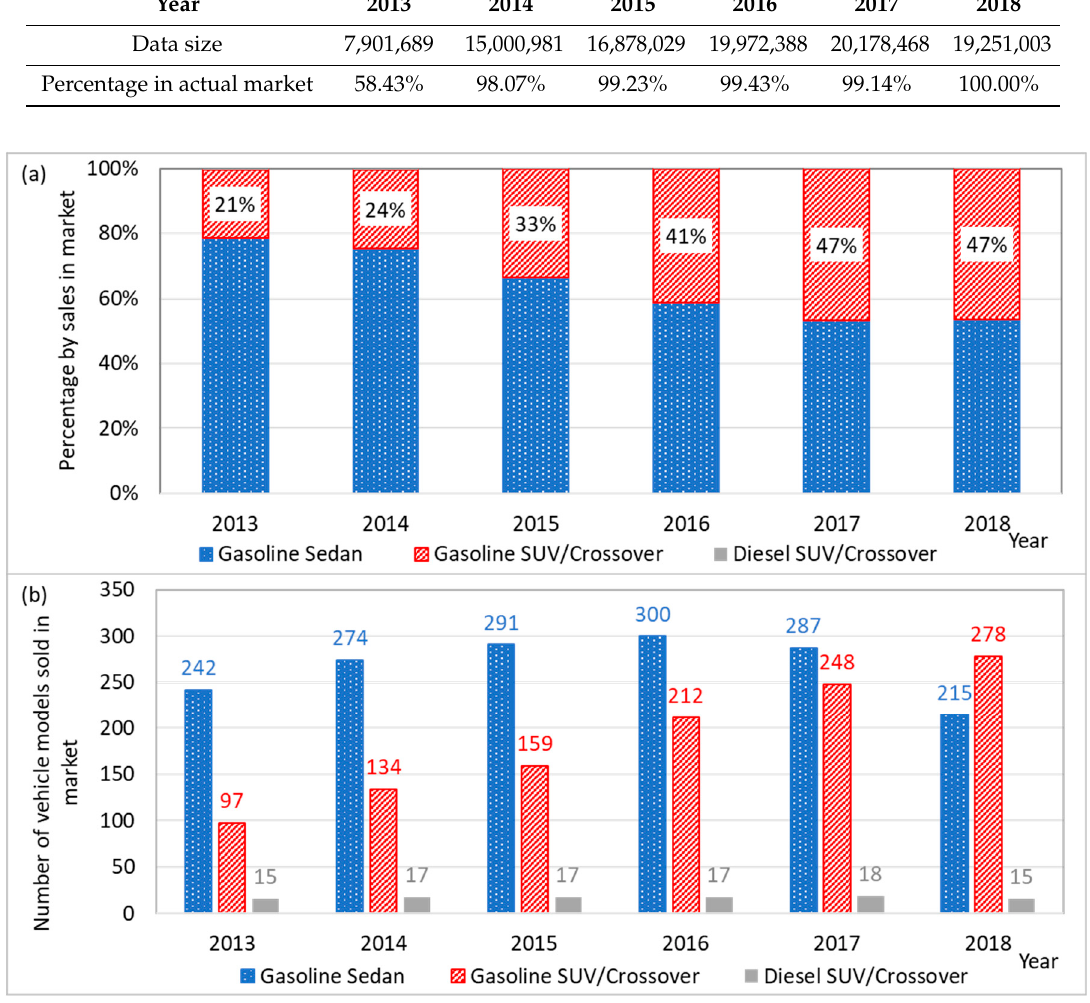
Figure 2. ( a ) Sales percentages by vehicle type in the Chinese market; and ( b ) number of vehicle models by vehicle type,